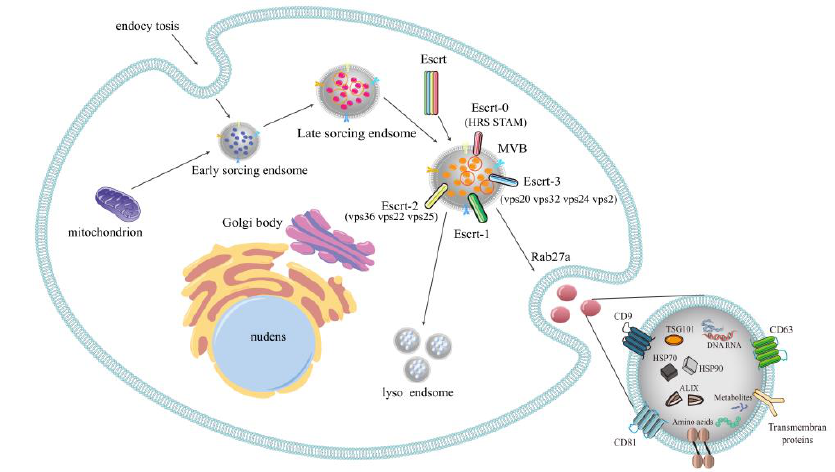
Figure 1. Production and secretion of exosomes. Exosome production involves double invagination of the plasma membrane and the formation of intracavitary vesicles (ILVs) and polyvesicles (MVBs). The first invagination of the plasma membrane forms early sorting endosomes (ESE), which then develops into mature late sorting endosomes (LSEs), and finally MVBs. MVBs contains multiple ILVs. MVBs are degraded by fusion with lysosomes or autophagosomes, or fuse with plasma membranes to release the ILVs contained in MVBs (exosomes). The secretion and transport of exosomes are mainly mediated by the Endosomal sorting complex Required for transport (ESCRT) on the MVBs membrane. ESCRT is mainly composed of ESCRT-0, -I, -II and -III complexes. Escrt-0 (HRS and STAM) regulates content aggregation through ubiquitination dependent pathways, ESCRT-I and ESCRT-II (Vps36, Vps22 and double-copy Vps25) induce bud formation. Escrt-III is composed of four core subunits: Vps20, Snf7 (Vps32), Vps24, and Vps2, as well as accessory proteins Did2, Vps60, and Ist1, which mainly promote membrane separation and vesicle cleavage. In addition, Rab27a and Rab27b, members of the Rab family GTPases, act on the docking of MVBs to the plasma membrane. ARF6 is a regulator of ILVs budding and exosome biosynthesis, which can promote the formation of